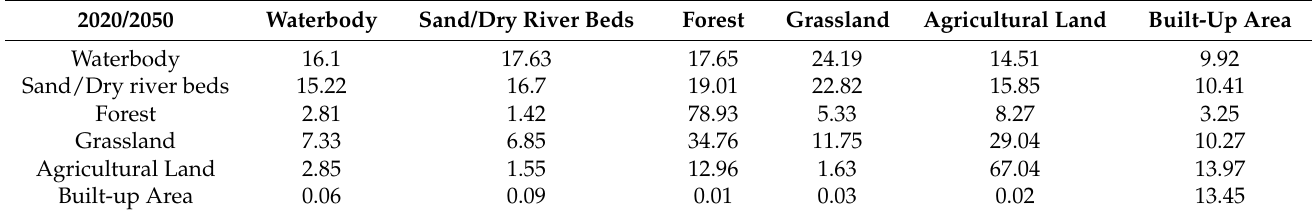
Table 10. Probability of LULC changes in 2050 by